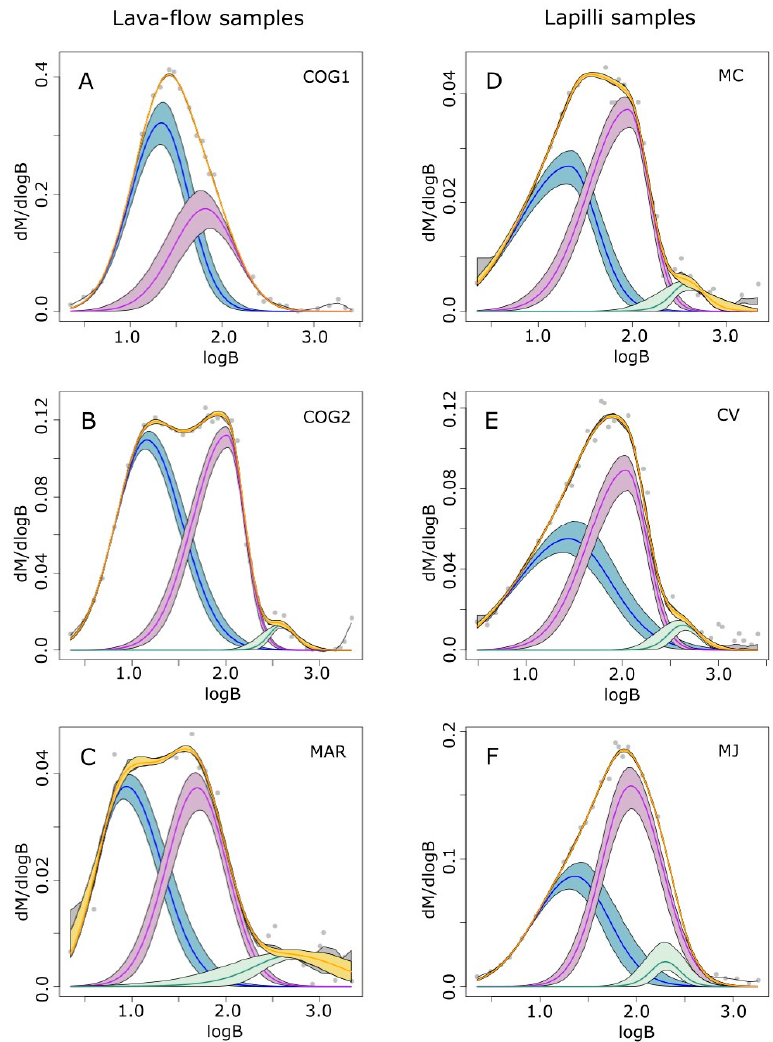
Figure 7. Unmixing diagrams ([37], see text) for three lava-flow samples ( A – C ) and three lapilli samples ( D – F ). The yellow line represents the final model adjustment. Adjustment for component 1 is represented in blue, for component 2 in purple, and for component 3 in green. Units: B in mT and M in Am 2 /kg.